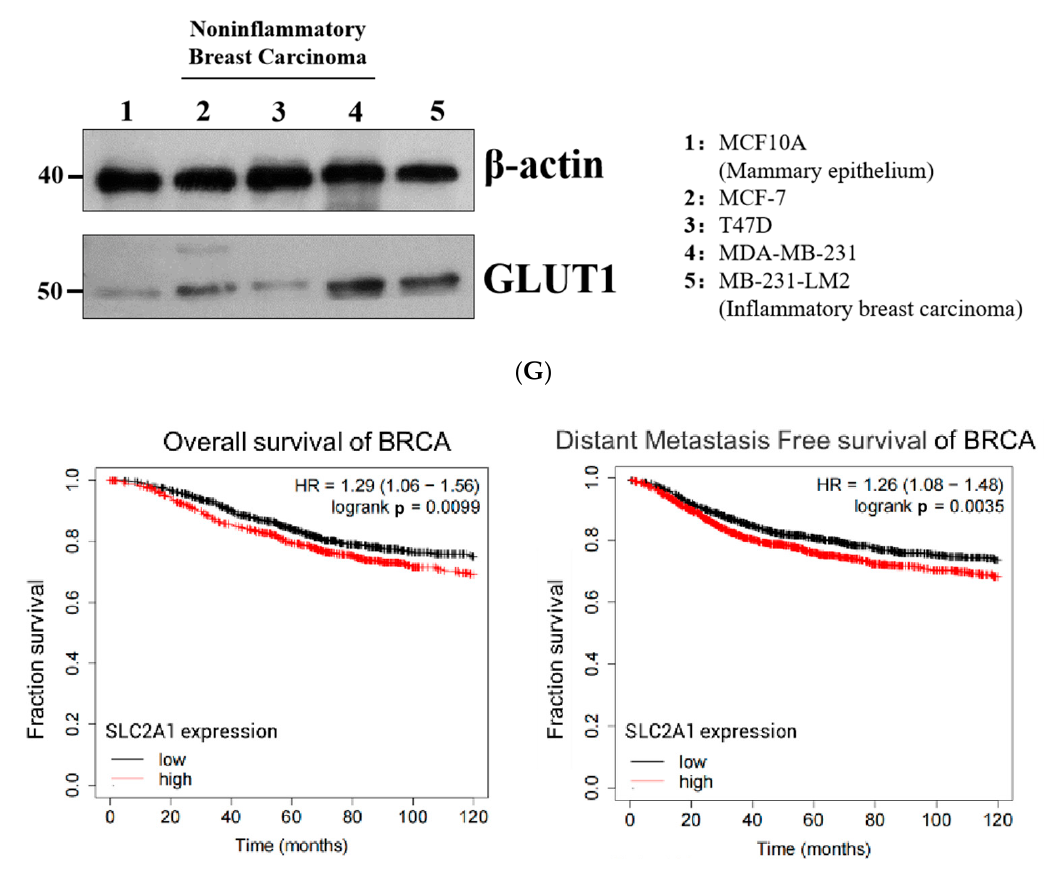
Figure 1. mRNA expression level of SLC2As in cancer tissues and subtypes of breast cancer correlated with low survival rate of patients. ( A ) High levels of lactate production in different subtypes of breast cancer calculated using the depmap portal. ( B ) Lactate concentration and ( C ) glucose uptake and glucose consumption in MCF10A, MCF-7, T47D, and MDA-MB-231 cells. ( D ) Differentially expressed genes (DEGs) between tumor and normal in BRCA. mRNA expression levels of SLC2A1 in normal and breast cancer tissues calculated using ( E ) GSCA and ( F ) GEPIA database; * p < 0.05 versus normal tissue. ( G ) Protein lysates were subjected to Western blot analysis for the expressions of GLUT1 and β -actin in different subtypes of breast cancer. ( H ) Relationship between SLC2A1 expression and OS and DMFS in breast cancer patients. (Plots showing low expression in black and high expression in red by KM analysis, with median cutoff values. p values were calculated using the log-rank test). Data are expressed as the mean ± Standard Error of Mean (SEM). * p < 0.05 versus MCF10A cells; ** p < 0.01 versus MCF10A cells; **** p < 0.0001 versus MCF10A cells.